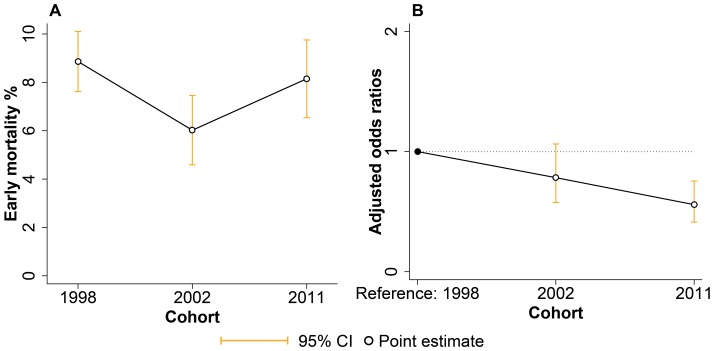
Unadjusted and adjusted comparison of early hospital mortality across cohorts.
A. Unadjusted early hospital mortality rates across cohorts. B. Odds ratios for the 2002 and 2011 cohorts when treated as indicator variables in a multivariate logistic regression analysis with early hospital mortality as the dependent variable. The model was adjusted for sex, age, mechanism of injury and ICISS. Abbreviations: ICD International Classification of Disease, ICISS ICD-derived Injury Severity Score.